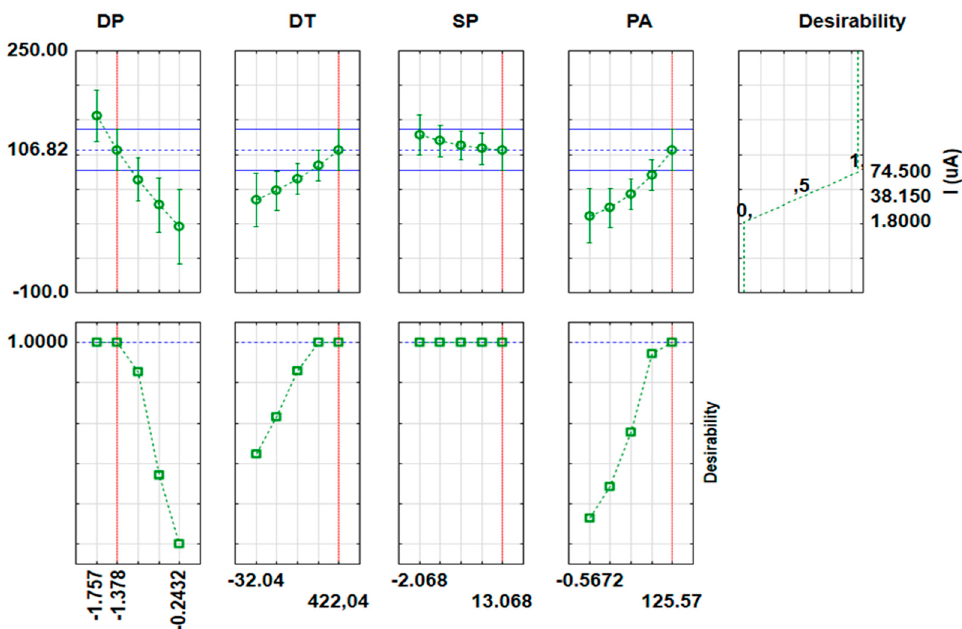
Figure 9. Profiles for predicted values and desirability of Zn(II).